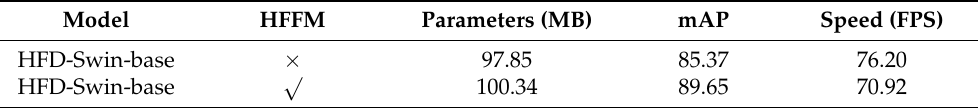
Table 4. The effectiveness of the hierarchical feature fusion module for HFD with Swin-base.